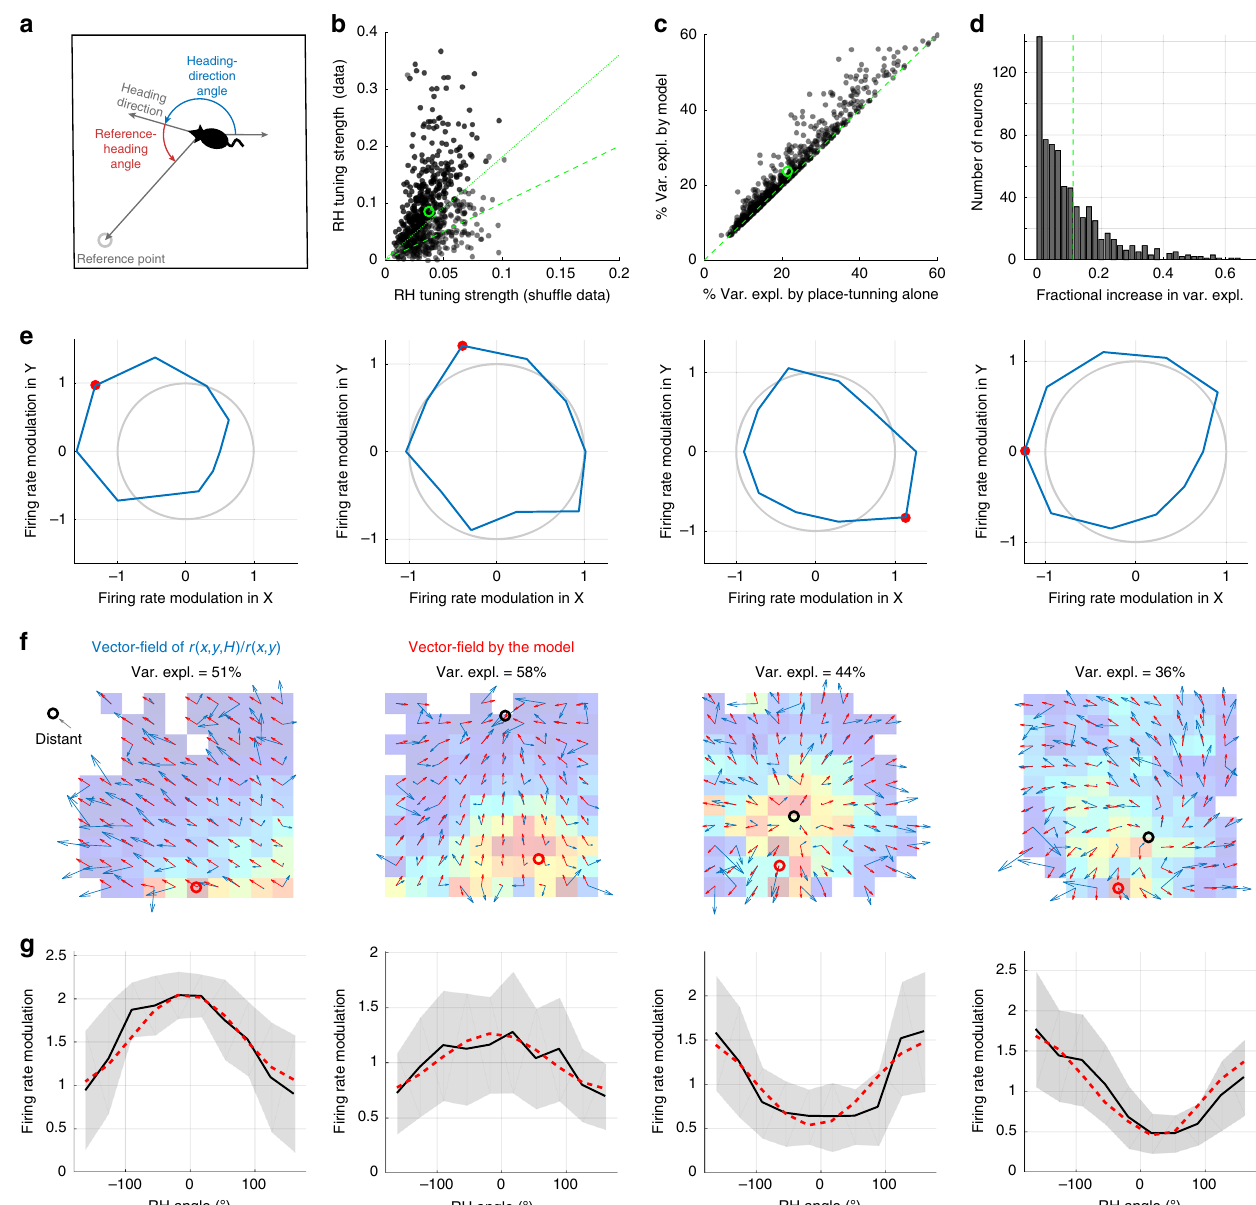
Fig. 2 Model of modulation by heading direction relative to a reference point. a De fi nitions of the reference point and reference-heading (RH) angle. b RH- angle tuning for the recorded population of neurons compared to the tuning for surrogate data with randomly shuf fl ed heading directions. Green circle is de fi ned as in Fig. 1. 86% of the neurons are above the equality line (dashed line), and 56% are above the 95% con fi dence line (dotted line). c Variance explained by the model with both RH angle and place modulation compared to a purely spatial description. d Histogram of the fractional change in variance, de fi ned as the change in variance due to RH modulation divided by the variance explained solely by place modulation. e Heading-direction tuning with spatial tuning removed over the full range of ±180 degrees divided into 10 bins. The eccentricity (around the circle of mean rate) of the polar plot represents the heading-direction modulation of the fi ring rate. f Same example cells as in e , showing spatial tuning (heat map), heading-direction tuning (blue arrows), and RH-angle tuning as fi tted by the model (red arrows). Black circles are the reference points obtained by the model. Reference point far from the arena enclosure is noted by an arrow with the word “ distant ” pointing toward the reference point. g RH-angle tuning responses fi tted by the model. Shaded area is the ±std.dev. These tunings are comparable with reports in bats